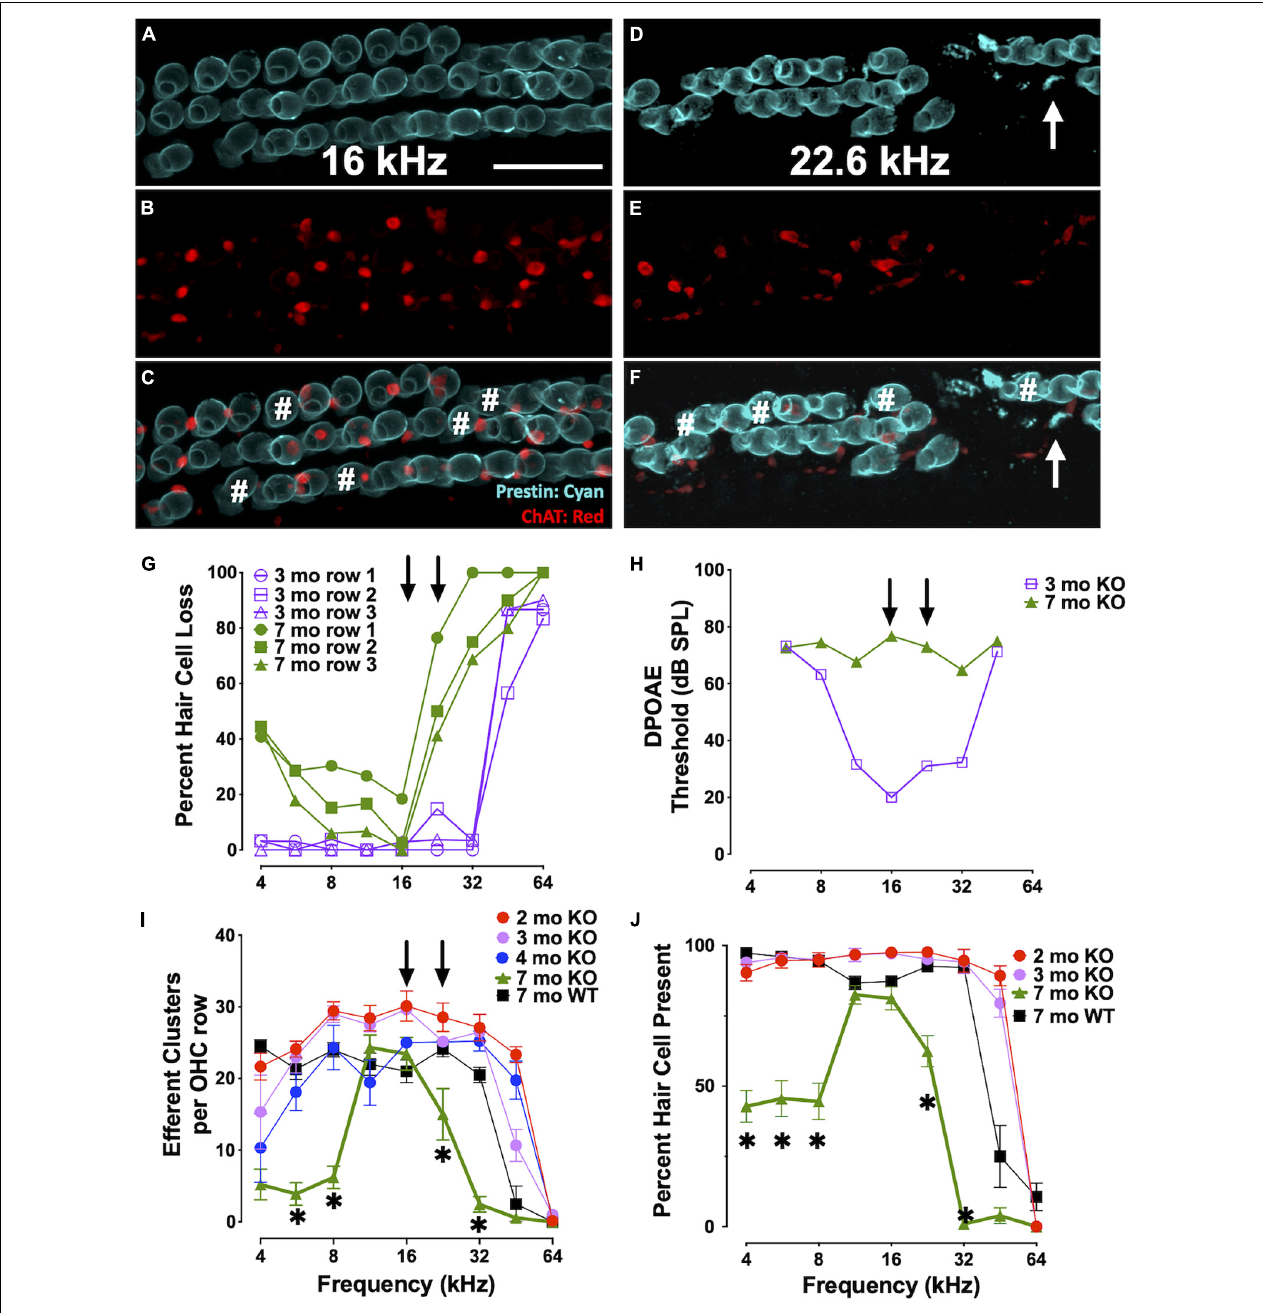
FIGURE 6 | Elevated thresholds occur even when OHCs and efferent clusters are present. (A–F) Surface preparations of a 7 mo CBA KO cochlea co-labeled with prestin (teal) and ChAT (red) in the 16 and 22 kHz regions of CBA KO mice. # OHCs without ChAT clusters. Arrows point to OHC fragments. Quantification of this 7 mo is shown in panels (G) and (H) . (G) % of OHCs missing from each OHC row from a single 3 mo and 7 mo CBA KO animal. Arrows point to 16 and 22 kHz frequencies. (H) DPOAE thresholds of 3 mo and 7 mo from panel (G) . Arrows point to 16 and 22 kHz frequencies. (I) Quantification of the number of ChAT-labeled efferent clusters from CBA KO animals from 2 to 7 mo ( n = 3/age). (J) Quantification of the number of OHCs from CBA KO animals from 2 to 7 mo ( n = 3/age). Scale represents 40 µ m. Asterisks represent significance ( p < 0.05) from 2 mo at 16 and 22 kHz.